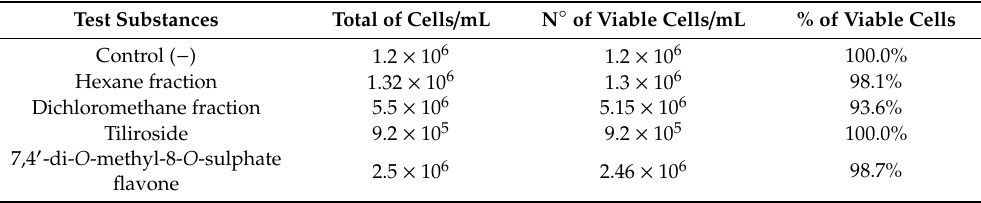
Table 2. Cells counted in the Neubauer chamber, using a fluorescence microscope.